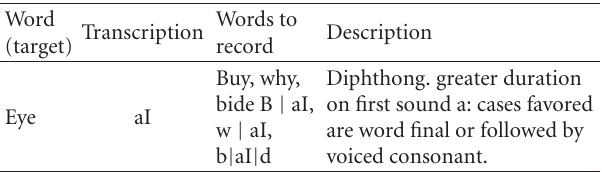
Table 1: The design